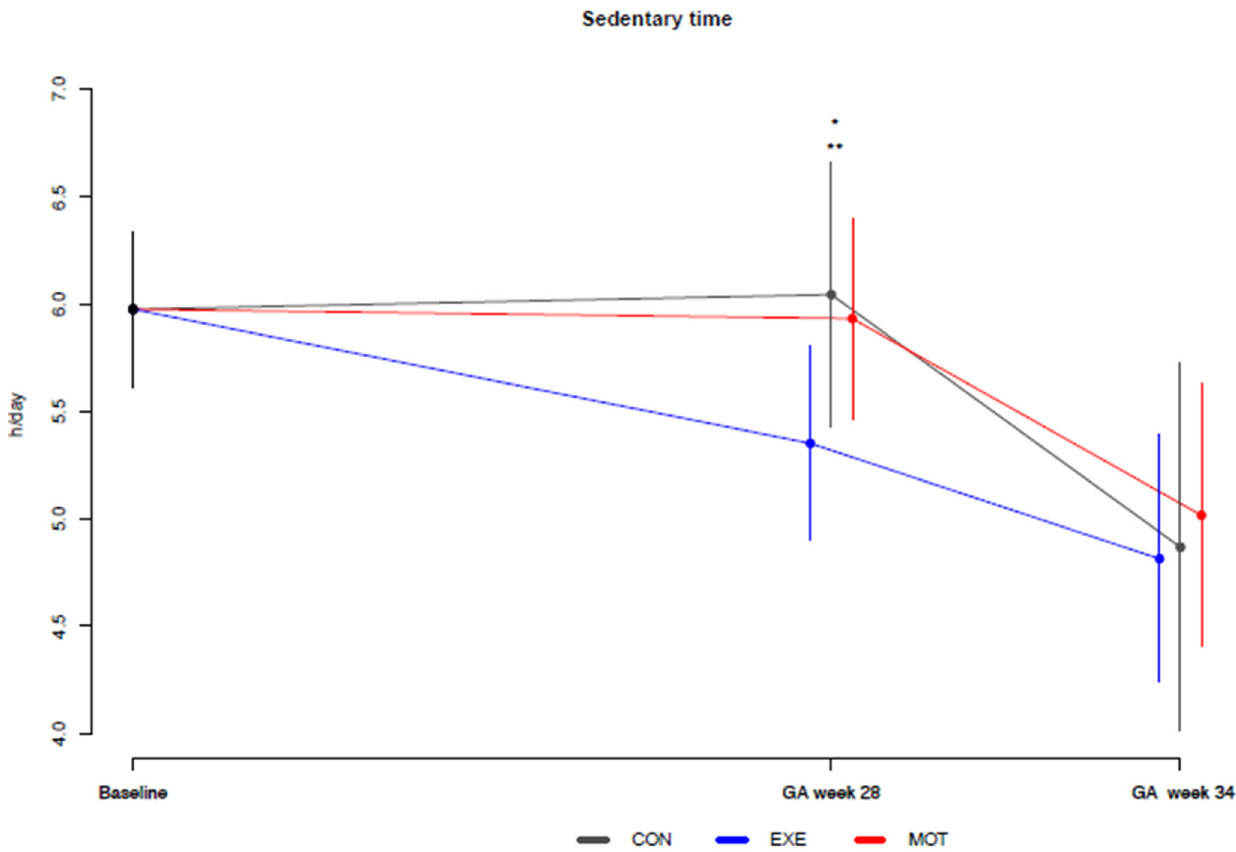
Figure 2. Baseline-constrained comparison between groups based on the means of sedentary time from the Pregnancy Physical Activity Questionnaire. Baseline, gestational age of maximum 15 weeks; CON (grey color), standard care; EXE (blue color), structured supervised exercise training; GA, gestational age; hr, hour; MOT (red color), motivational counseling on physical activity. * EXE compared to CON at GA week 28 ( p = 0.0498), ** EXE compared to MOT at GA week 28 ( p = 0.042).